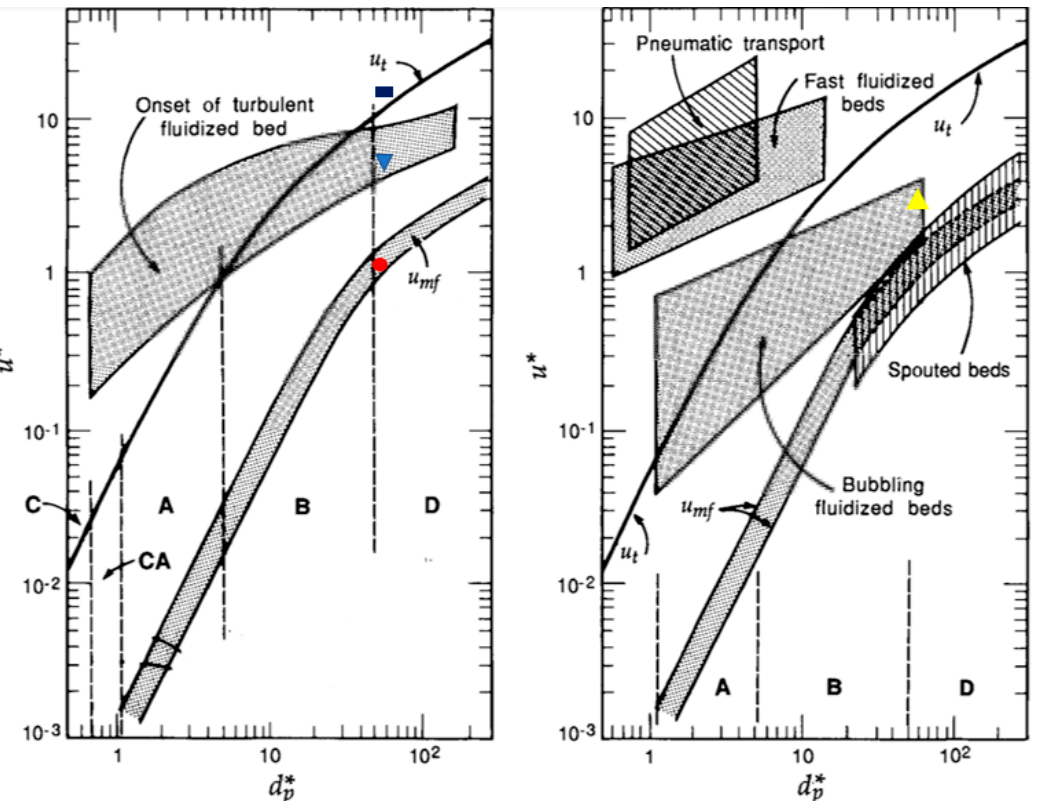
Figure 9. General fluidization regime diagrams from packed bed to pneumatic transport of particles [31]. Letters A, B, C, and D refer to the Geldart classification of particles. u t is the terminal velocity which is free-fall velocity of a particle through the fluidization gas.